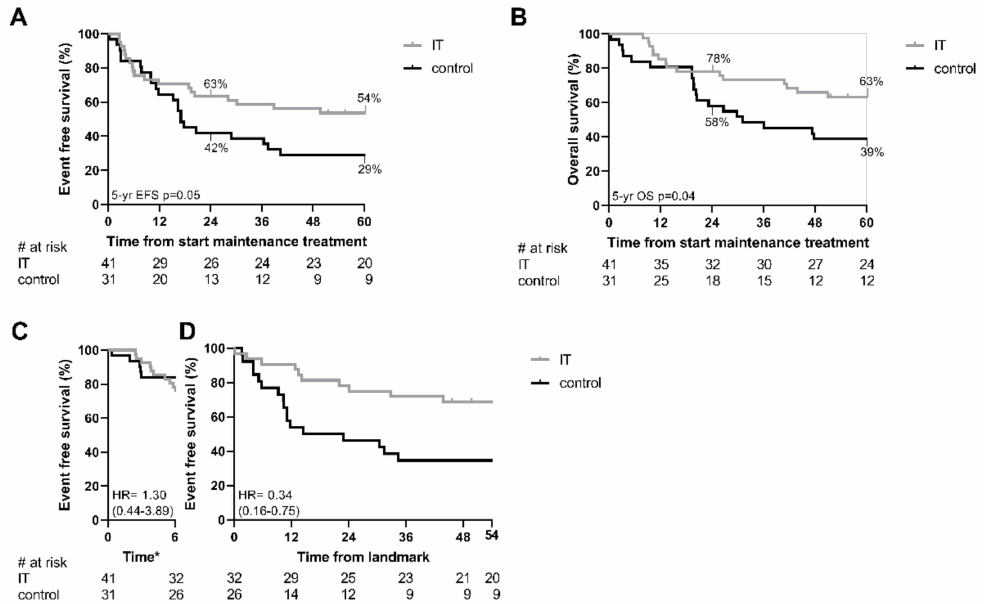
Figure 2. Estimated event free and overall survival of patients ≥ 18 months. ( A , B ) Estimated event free survival (EFS; A ) and overall survival (OS; B ) in months from start of the maintenance treatment for patients ≥ 18 months of age at diagnosis, treated with immunotherapy (IT) or single-agent isotretinoin (control). Numbers at risk are given for 12 month intervals below the graphs. ( C , D ) EFS, with a landmark at the end of treatment, 6 months after start of maintenance treatment. ( C ) shows EFS from start of maintenance treatment to landmark (6 months after start of treatment). ( D ) shows EFS from landmark until 5 years after start of maintenance treatment (54 months from landmark). Estimated survival and p -values are calculated by Kaplan–Meier method. Numbers at risk are given for 12 month intervals below the graphs. * Time from start maintenance